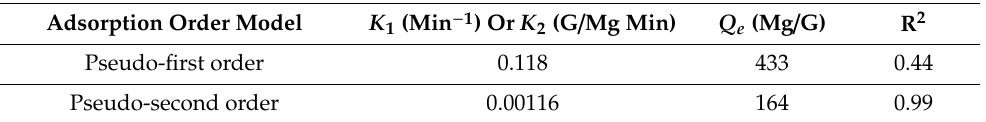
Table 2. Adsorption kinetics parameters for pseudo-first and pseudo-second orders of Doxycyline adsorption onto